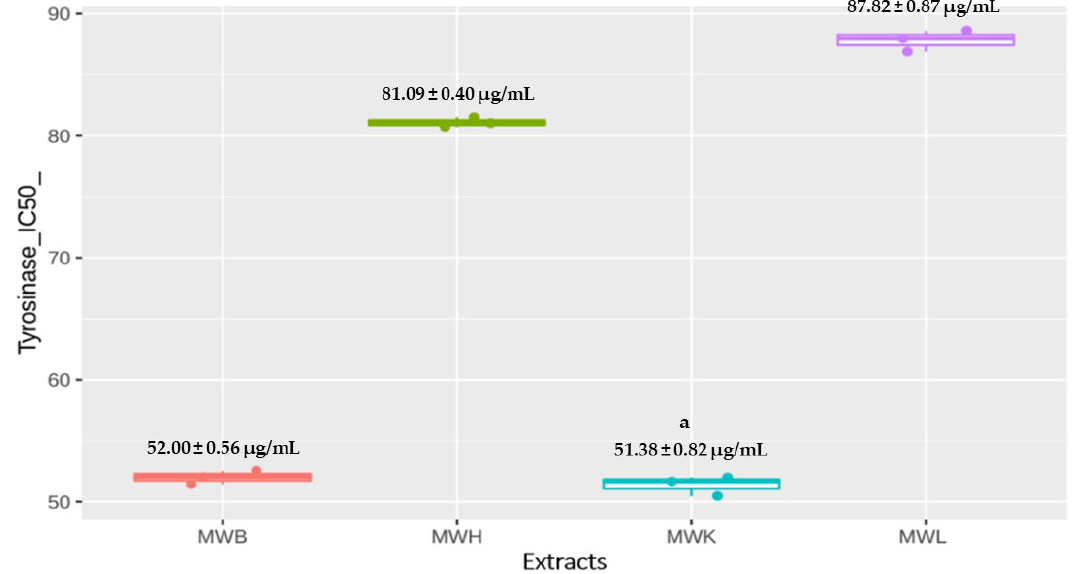
Figure 3 . Effect of J. regia methanolic extracts on tyrosinase activity. a p < 0.05, Data expressed as mean ± SD. Abbreviations—MWB: Methanolic Extract of bark, MWH: Methanolic extract of